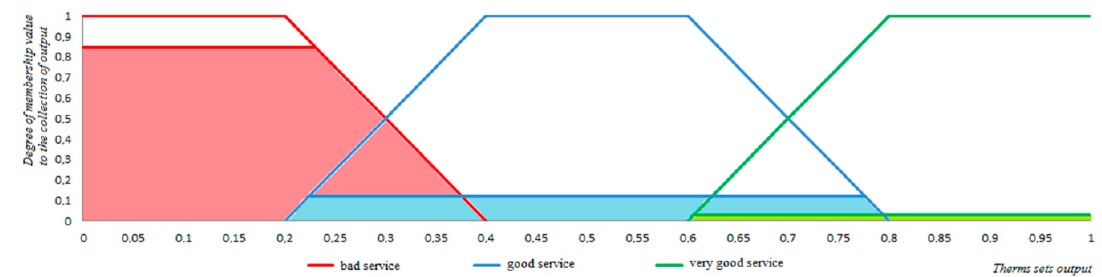
Figure 6. Accumulation membership functions of output set B(y).